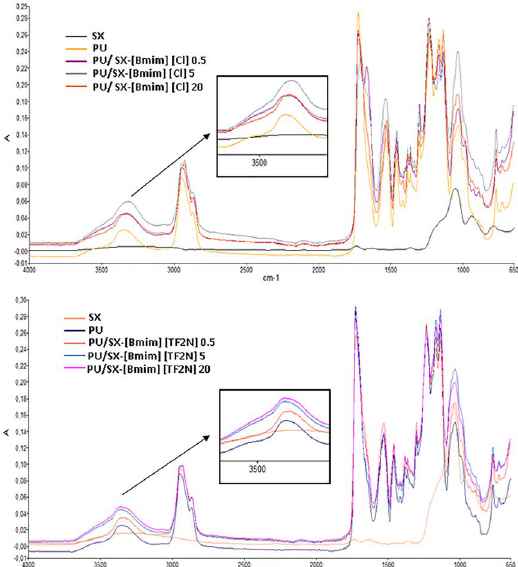
Figure 3. FTIR spectra for functionalized silica xerogels, PU and PU composites. PU and PU composites FESEM images clearly show